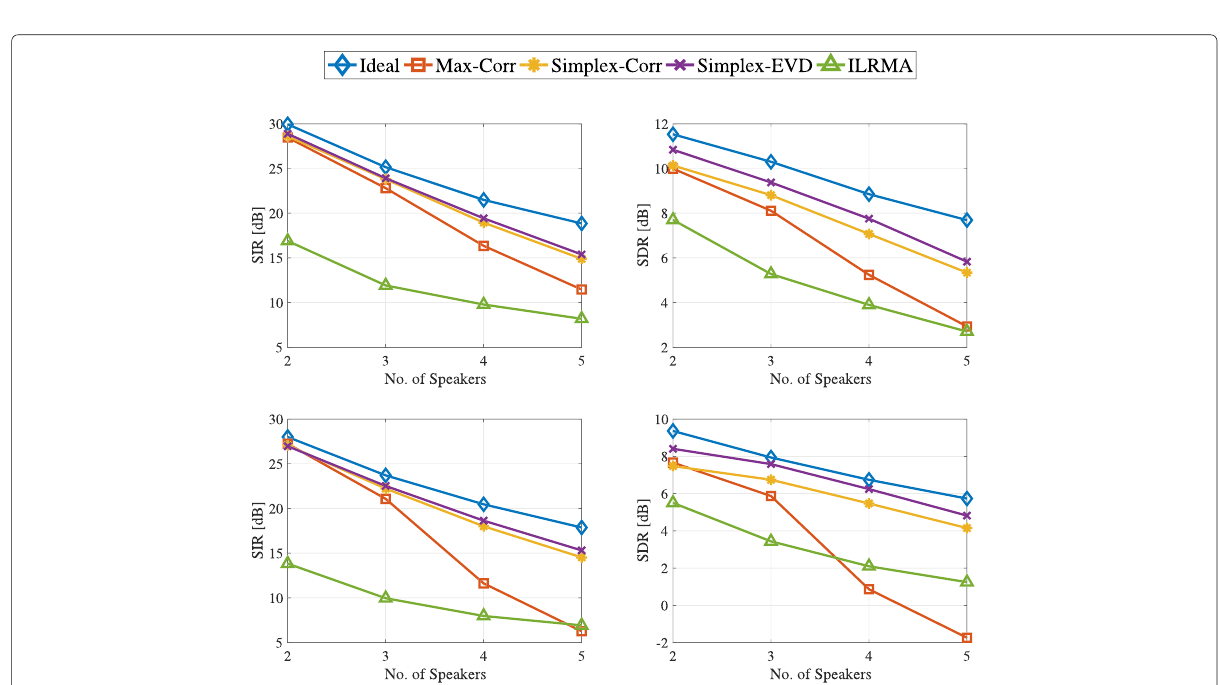
Fig. 7 Distributed array: evaluation for mixtures with balanced activity—performance as a function of the number of speakers for a , b low and c , d high reverberation conditions and SNR = 20